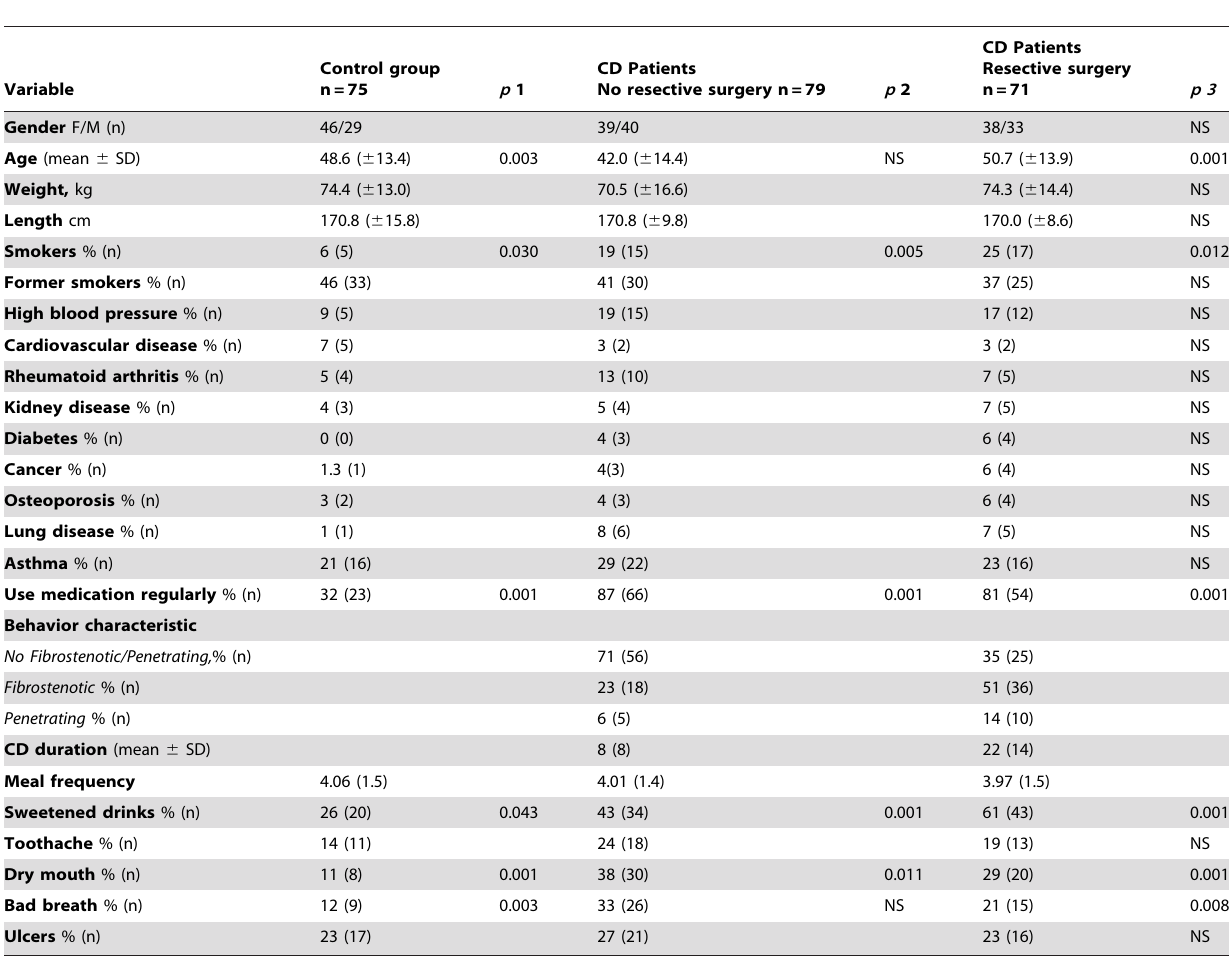
Table 1. Demographic data, mean (SD) and percentages (number) for the CD patients (who had not and had undergone resective surgery) and the